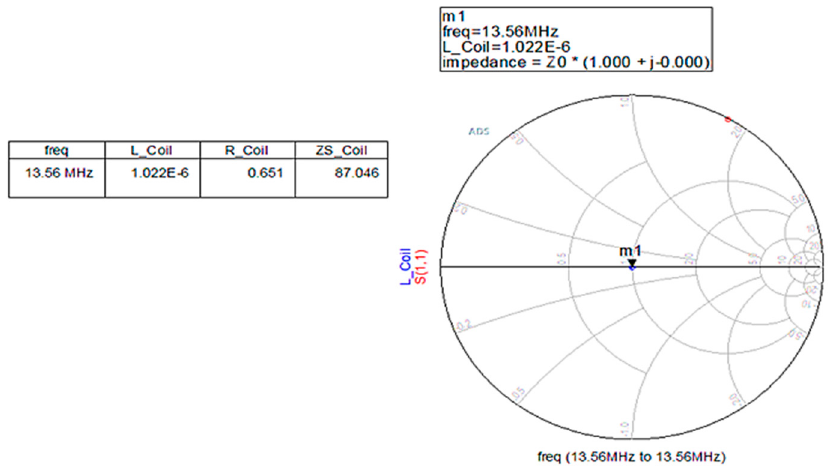
Figure 11. Simulation result of the receiver coil optimization in ADS momentum.